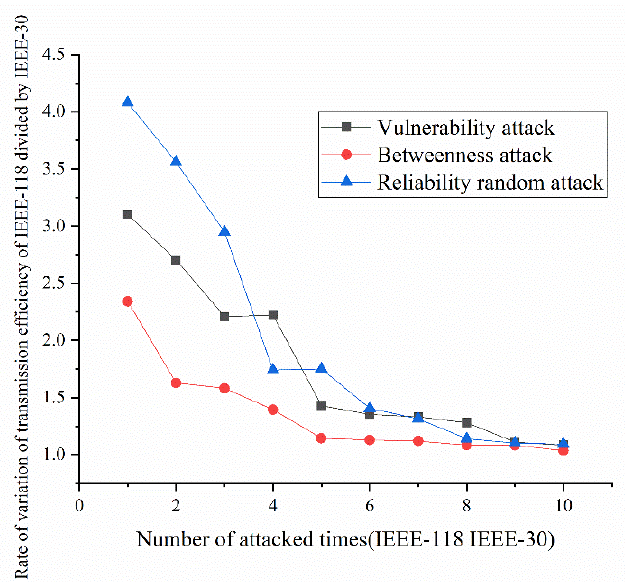
Figure 26. Rate of transmission efficiency under the three set attack modes.